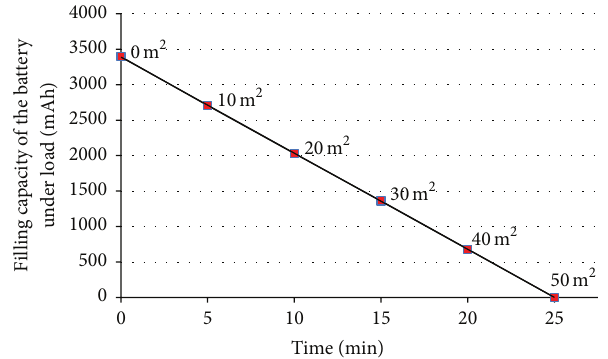
Figure 13: Time related change graph of field to be mowed and consumed electrical